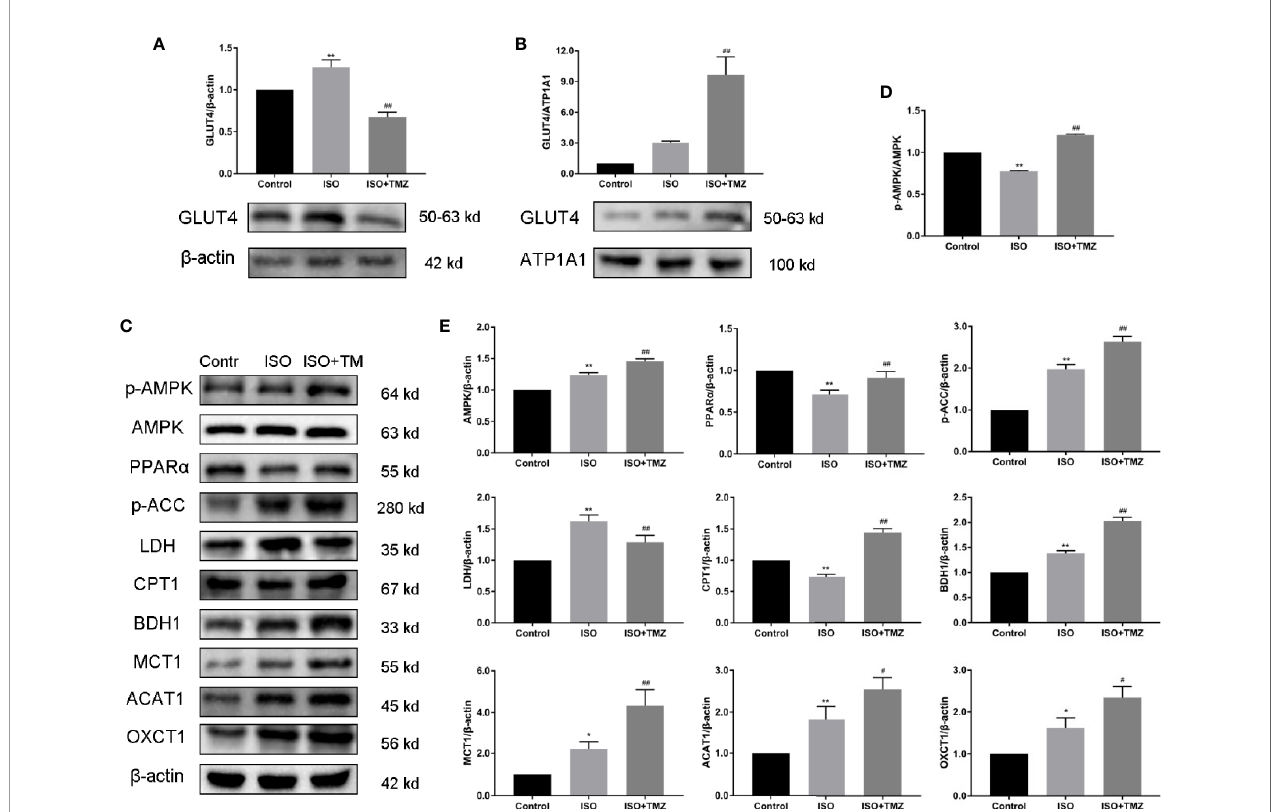
FIGURE 4 | Trimetazidine treatment promotes the protein expression related to myocardial substrate uptake and utilization in myocardial tissues of isoproterenol- induced heart failure rats. (A) Cytosolic protein was extracted and expression levels of cellular localization of GLUT4 were determined using Western blot. b -actin was choice as an internal control. (B) Membrane protein was extracted and expression levels of cellular localization of GLUT4 were determined using Western blot. ATP1A1 was chosen as an internal control. (C) Western blot was used to evaluate metabolism-related protein expression. AMPK, p-AMPK, PPAR a , p-ACC, LDH, CPT1, BDH1, MCT1, ACAT1, and OXCT1 were included. (D) Immunoblotting analysis was conducted to detect the ratio of p-AMPK/AMPK protein expression within myocardial tissues (n = 3). (E) The histogram indicated the speci fi c relevant quantitative results (n = 3). Data are represented as means ± SD, # P < 0.05, ## P < 0.01 compared with ISO group, *P < 0.05, **P < 0.01 compared with control group. p-AMPK, phospho-AMPK; AMPK, adenosine monophosphate-activated protein kinase; PPAR a , peroxisome proliferator activated receptor a ; p-ACC, phospho-acetyl-CoA carboxylase; LDH, lactate dehydrogenase;CPT1, carnitine palmitoyltransferase 1; BDH1, b -hydroxybutyrate dehydrogenase 1; MCT1, monocarboxylate transporter 1; ACAT1, acetoacetyl-CoA thiolase 1; OXCT1(SCOT1), succinyl-CoA:3-ketoacid-CoA